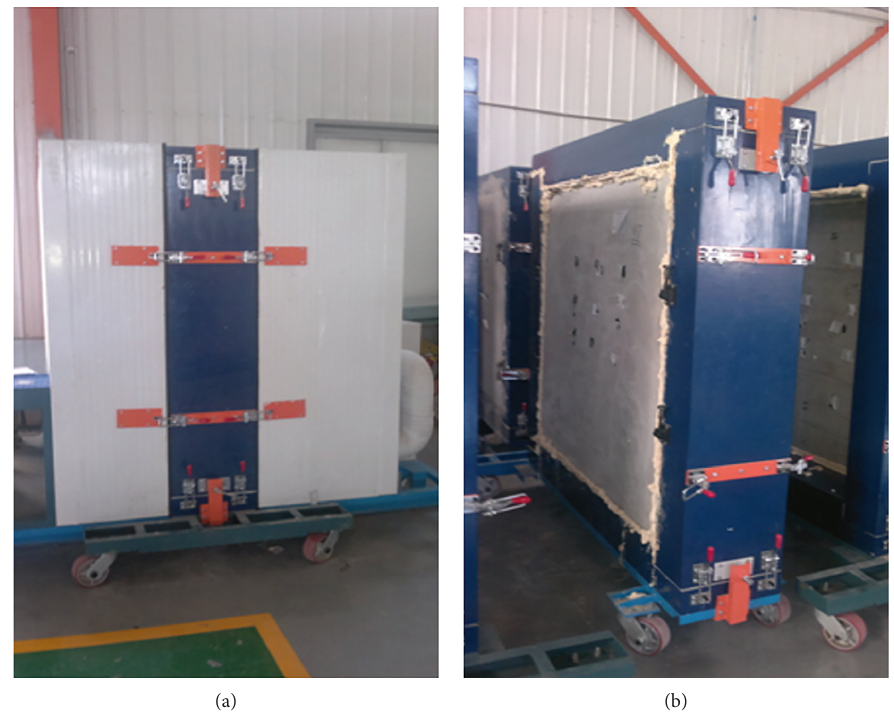
Figure 3: The external view of the environment control climate apparatus (a), and the sample box